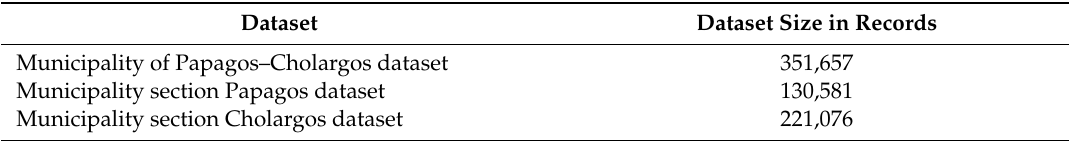
Table 8. Dataset